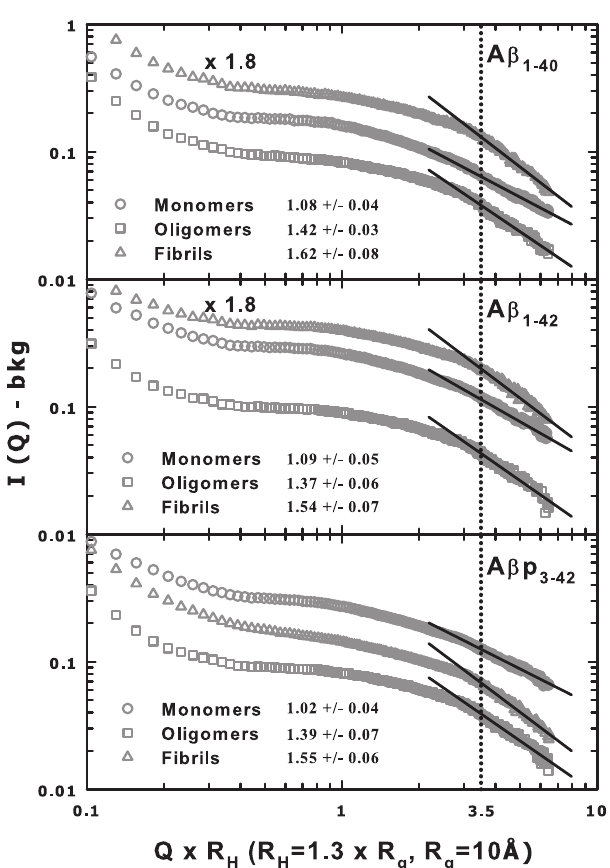
Figure 3. Background subtracted data as a function of Q · R H , with R H = 13 Å, in a log–log plot. for monomers, oligomers and fibrils of the three investigated peptides. Data of fibrils in the top and middle panels have been rescaled by multiplying for 1.8 to avoid overlaps. We have performed a linear best-fit for Q · R H ≥ 3.5 (Porod region) to get indications about the fractal structure of the systems and the obtained slopes are reported in the corresponding